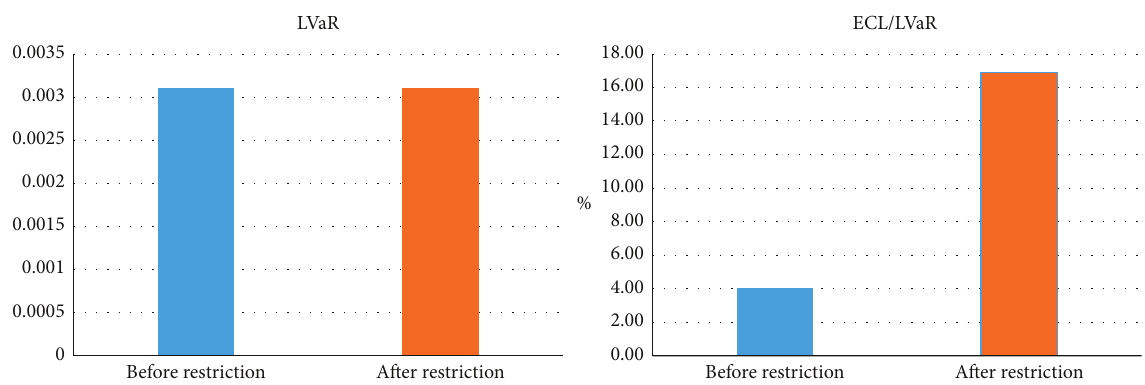
Figure 6: Comparison of ECL/LVaR and LVaR influenced by HFT behaviour. Figure 5 that the mean value and volatility of ECL/LVaR rose obviously after the trade restriction policy.